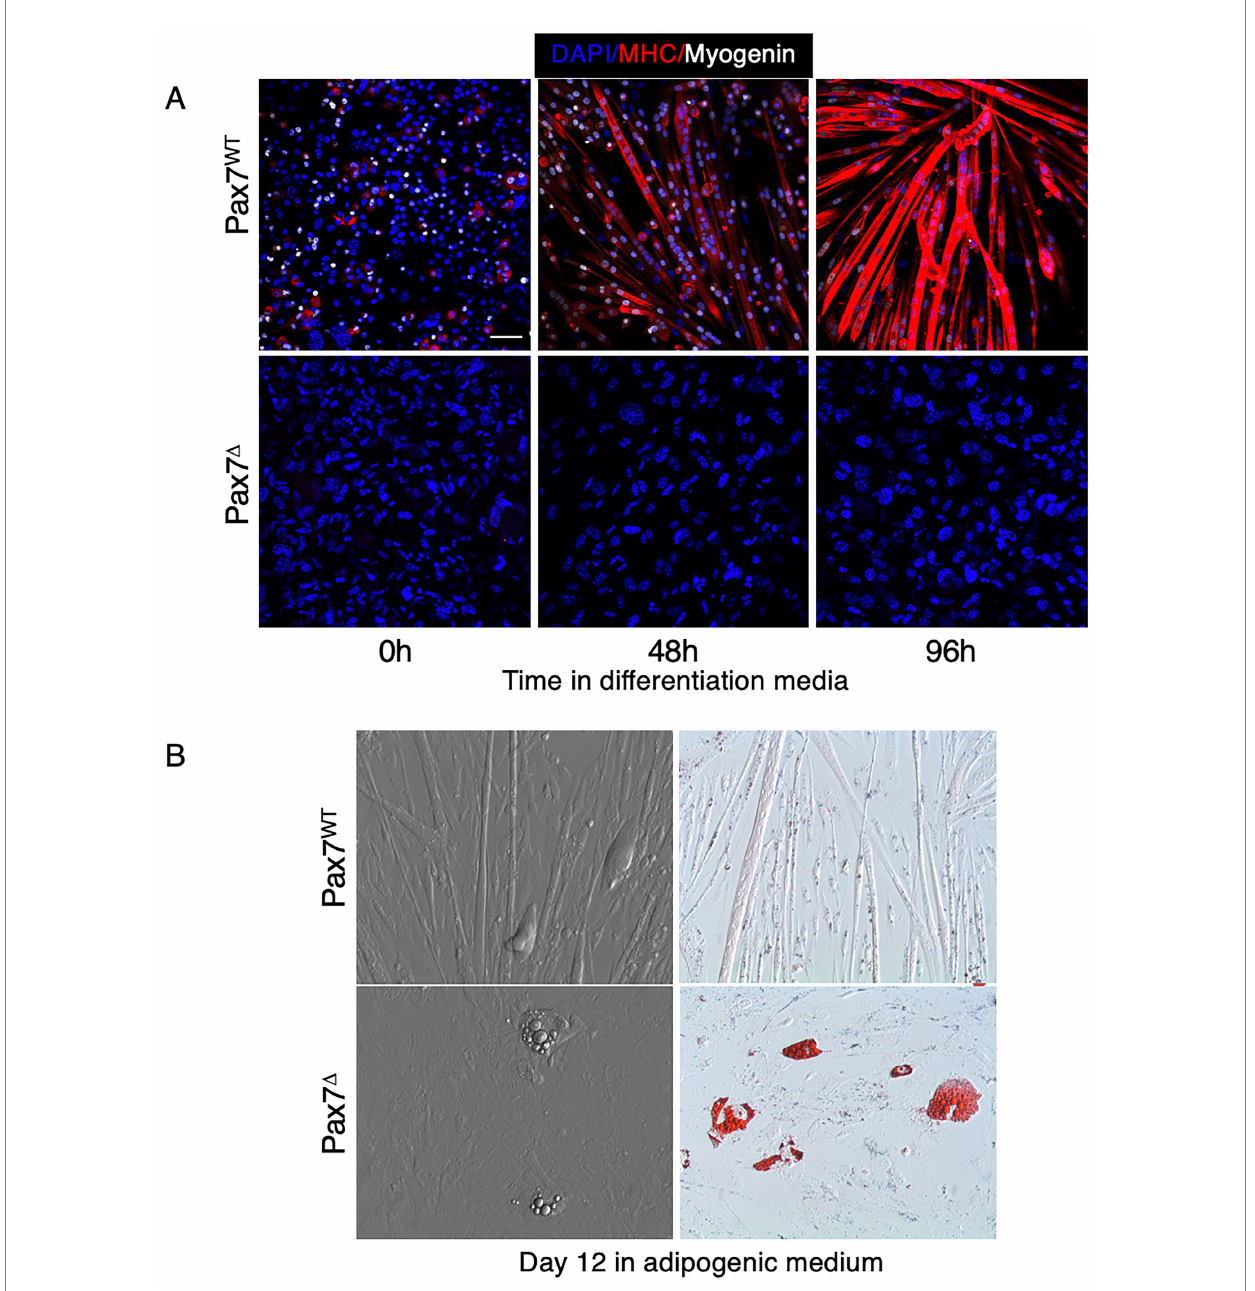
FIGURE 8 Myoblasts isolated from Pax7-depleted muscle fail to differentiate under hypoxic conditions and display increased adipogenesis. (A) Pax7 WT myoblasts in differentiation medium expressed myosin heavy chain (MHC) under hypoxia whereas Pax7 Δ cells failed to fuse and did not express the early differentiation marker myogenin or MHC. (B) When grown in adipogenic medium, Pax7 Δ myoblasts had a higher propensity to form oil red O + lipid droplets. Similar results were observed in three independent experiments. Scale bars = 100 μ